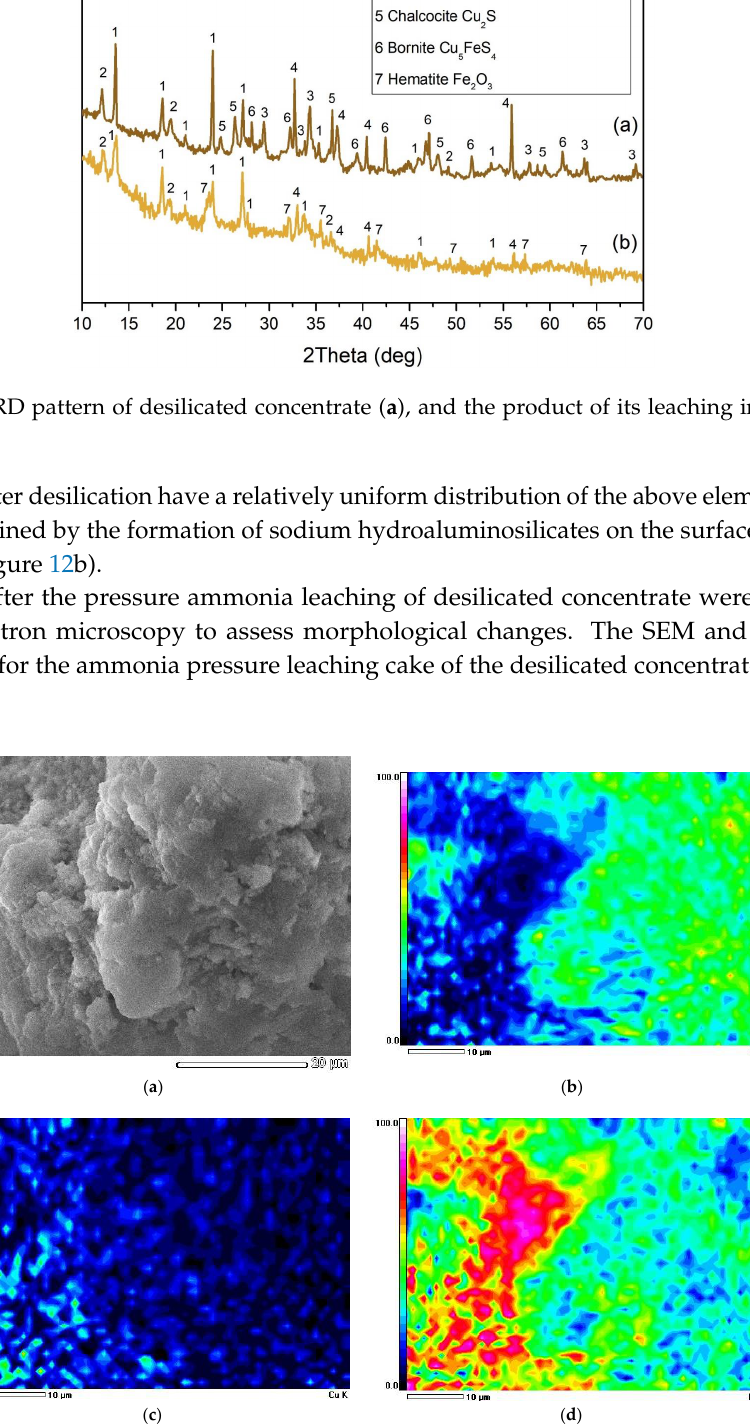
Figure 14. SEM image of ammonia leaching residue ( a ), and map-scans ( b , c , d ) for Si, Cu and Ag, respectively. According to the SEM images, the residue after ammonia pressure leaching is represented by particles larger than 30 μm with a rough surface (Figures 14a). The diffraction pattern of this cake (Figure 13b) shows that cancrinite and hematite are the main minerals in the material. The copper content decreases significantly after ammonia pressure leaching (Figure 14c). It follows that preliminary alkaline desilication makes it possible to reduce the diffusion limitations caused by aluminosilicates and quartz (into which sulfide minerals are apparently finely impregnated) due to the formation of a porous surface during leaching. A schematic diagram of the process is presented in Figure 15.